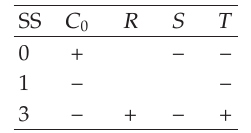
Table 2: The number of positive steady states (cid:4) SS (cid:5) is determined by the signs of the coe ffi cients (cid:4) 3.11 (cid:5) and the signs of the quantities R , S , and T from the Sturm sequence. Blank entries correspond to coe ffi cients which may take positive, negative, or zero